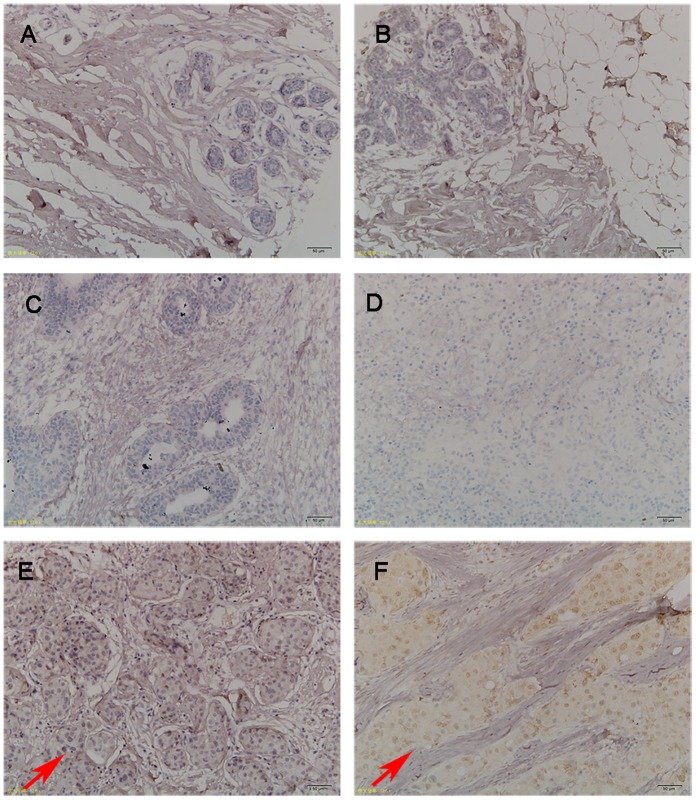
Expressions of TFDP3 in breast benign disease and breast cancer tissues (200×).The figure displays the immunohistochemical staining of: A, Normal breast tissue; B, Adenosis of breast; C, Breast fibroadenoma; D, Plasma cell mastitis; E, Invasive ductal carcinoma; F, Invasive ductal carcinoma. The arrows point to the TFDP3 positive expression cells.